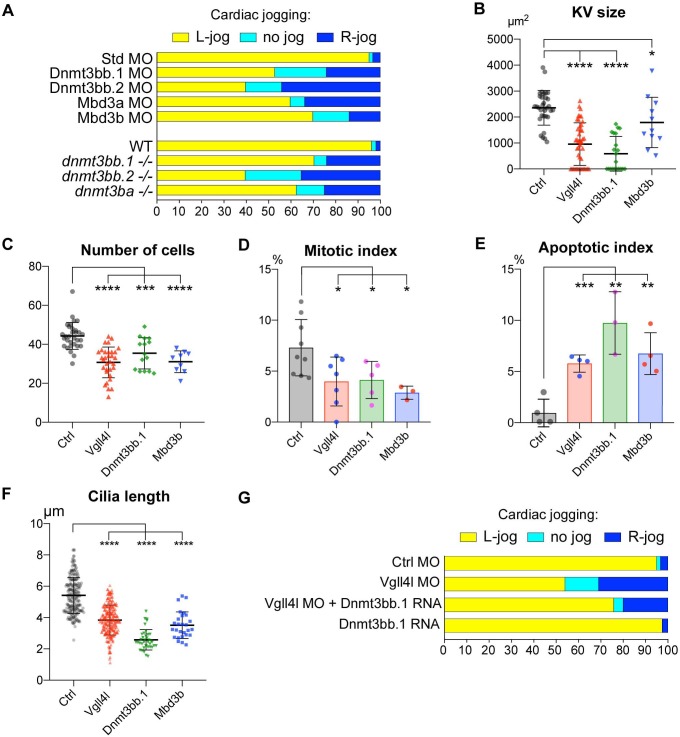
Similarity between phenotypes of Dnmt3bs, Mbd3s and Vgll4l loss of function in DFCs.(A) Loss of function of writers (dnmt3s) and readers (mbds) of DNA methylation marks strongly disrupt embryo laterality, analyzed by examining cardiac jogging at 25 hpf. Graphs indicate the percentage of embryos with normal Left jog (L jog - yellow), Right jog (R jog – dark blue) or no jog (light blue), at 25 hpf in control embryos (injected with 8 ng Standard - Std - MO), MO KDs (8 ng each MO) or in homozygous mutant embryos (-/-). (B–F) Phenotype analysis of LRO defects in morphants. (B) Size of the KV expressed in surface area of the planar projection of its lumen, (C) number of DFCs at the end of gastrulation, (D) Mitotic index at 80% epiboly, (E) Apoptotic index at gastrulation and (F) Length of KV cilia in : control (Ctrl) embryos (gray), Vgll4l (red), Dnmt3bb.1 (green) or Mbd3b (blue) MO knockdowns. Statistical significance between controls and loss of function conditions: two-tailed unpaired t-test. *p≤0.05, **p≤0.01, ***p≤0.001, ****p≤0.0001. Numerical data (A–H) and details of statistical analysis for (B–F) are provided in Figure 9—source data 1. (G) Injection of 100 ng of in vitro synthesized Dnmt3bb.1 RNA partially rescues laterality defects of Vgll4l morphants (8 ng Vgll4l MO), scored on cardiac jogging at 25 hpf.10.7554/eLife.45241.023Figure 9—source data 1.Numerical data for Figure 9A, B, C, D, E, F and G.